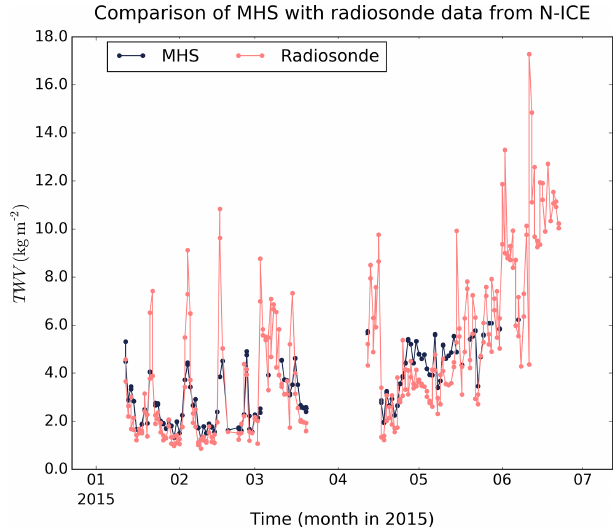
Figure 4. Time series of coincident MHS TWV data (blue sym- bols) and TWV from radiosondes (pink symbols) during the N-ICE